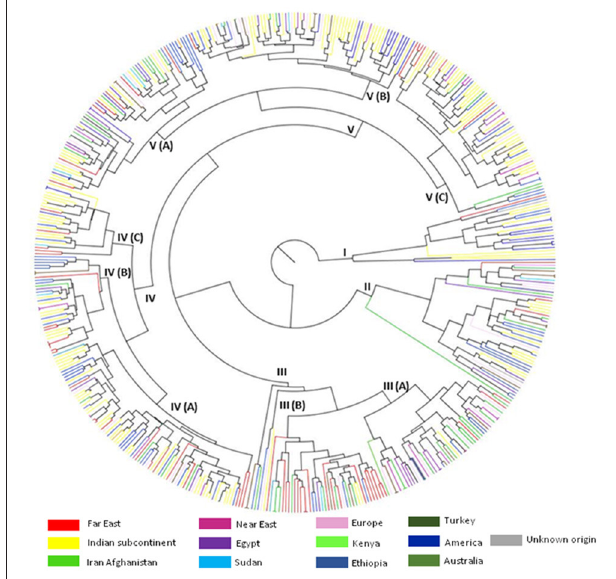
FIGURE 1 | UPGMA cluster analysis illustrating the genetic relationships between 531 safflower accessions based on 12 morphological traits. Five clusters (I–V) with internal sub-groupings are shown. Color codes correspond to region of